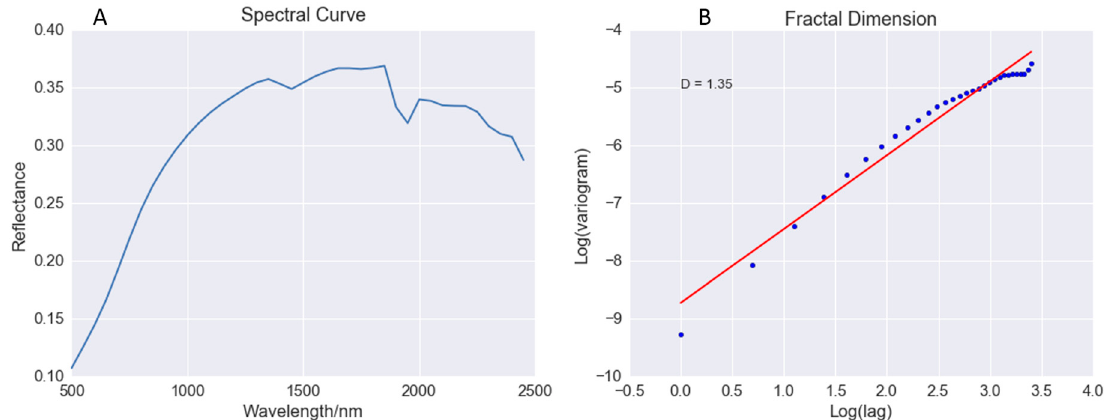
Figure 2. Illustration of fractal dimension calculation. ( A ) is the spectral curve and ( B ) is the corresponding log–log plot of variogram and lags and the fitted regression line.